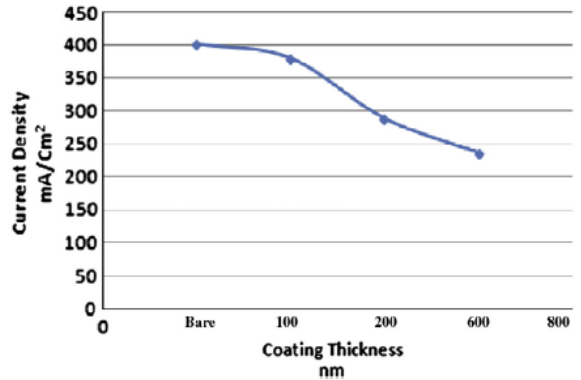
Figure 11. Current density vs. coating thickness graph AA-6061 [85].